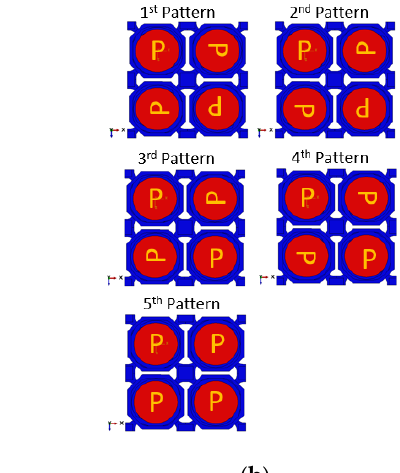
Figure 4. Annotation and patterns of the lattices. ( a ) Top view and front view of the unit cell; ( b ) Patterns of 2 × 1 × 2 lattices.